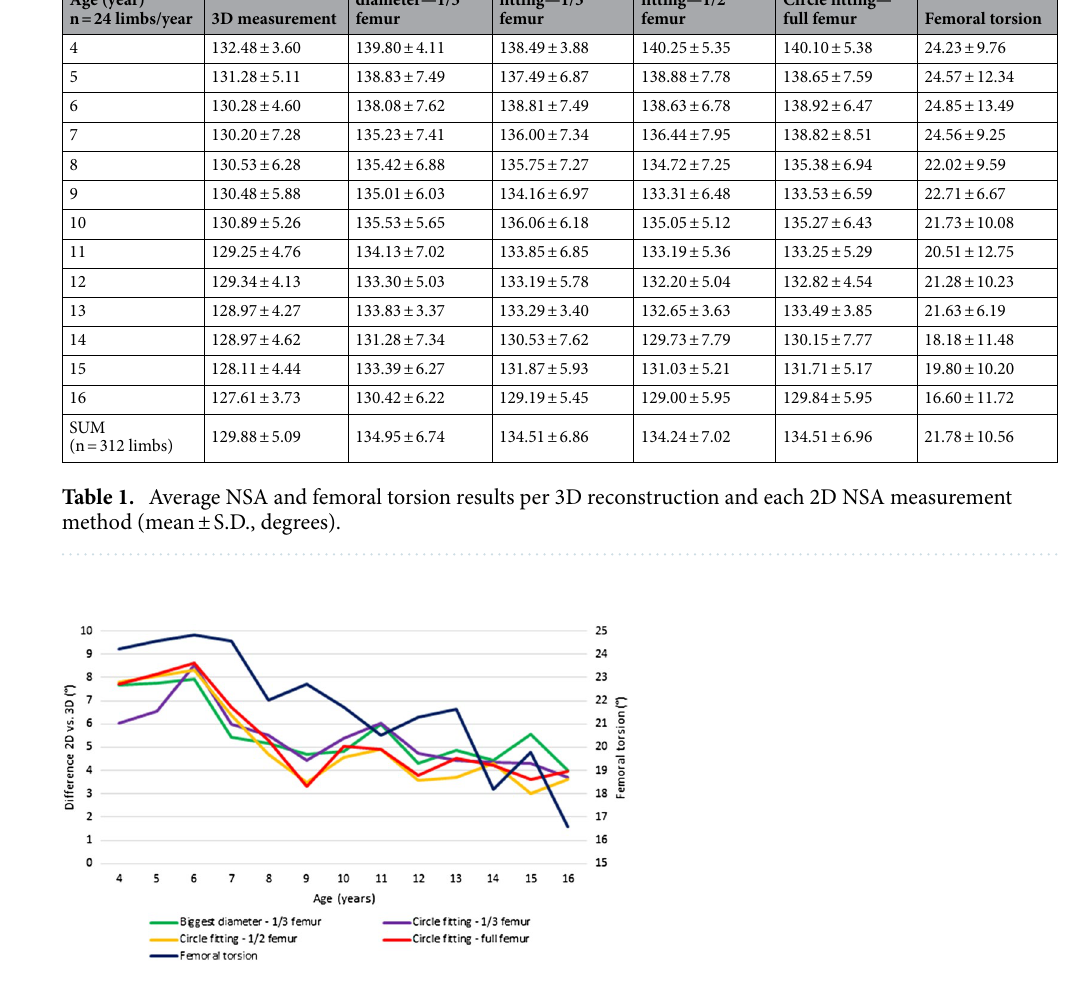
Figure 3. The average difference of the 3D reconstruction and the plain radiography-based NSA measurement results, in addition the average femoral